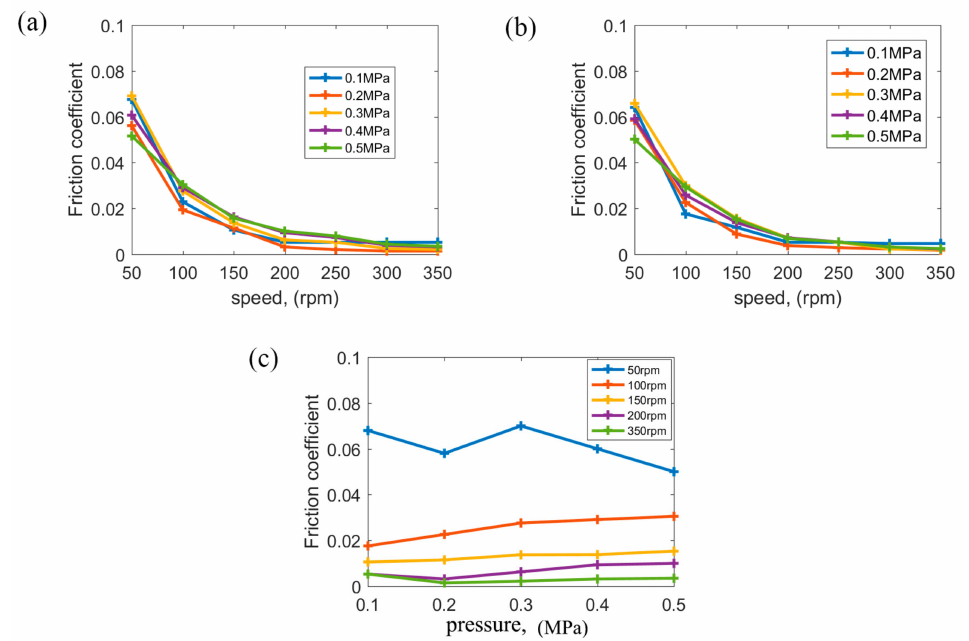
Figure 8. ( a ) COF vs. speeds with speeds ranging from high to low, ( b ) COF vs. speeds with speeds ranging from low to high, and ( c ) COF vs.